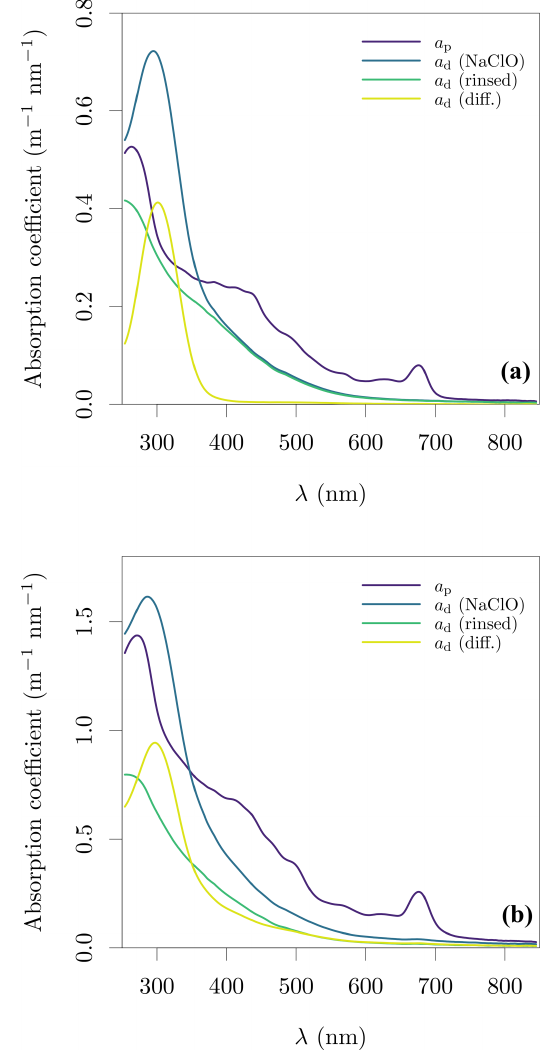
Figure 1. Chromophoric dissolved organic matter (CDOM) absorp- tion in the Belgian water systems. (a) CDOM spectral absorption coefficient, a g ; and (b) hyperbolic slope of a g , S h range of 380 to 850nm.